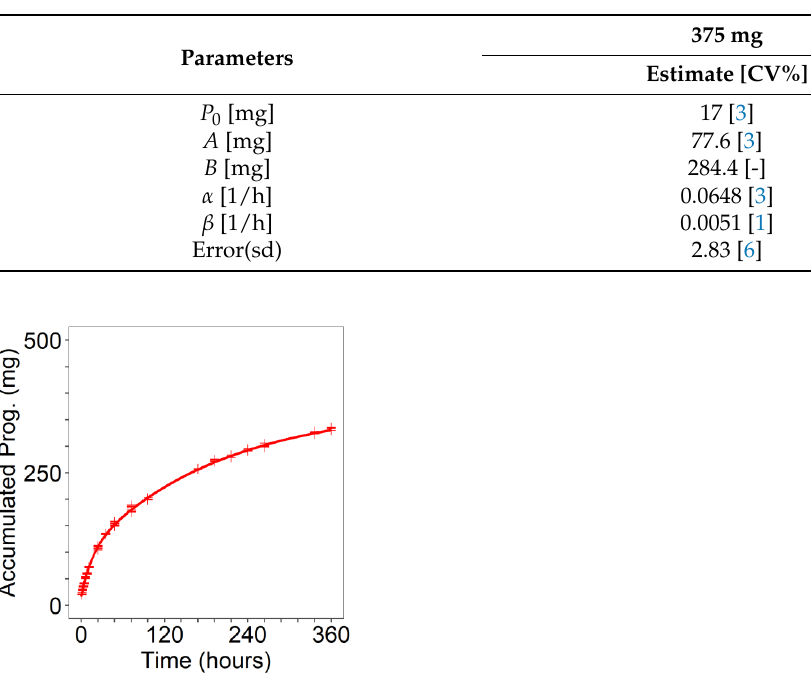
Figure A5. Observed in vitro individual data and fitted cumulative release profiles normalized by the progesterone dose loaded in the ring for all dose levels. Table A4. Parameter estimates of the in vitro release model for test batch (batch E) at 375 mg.